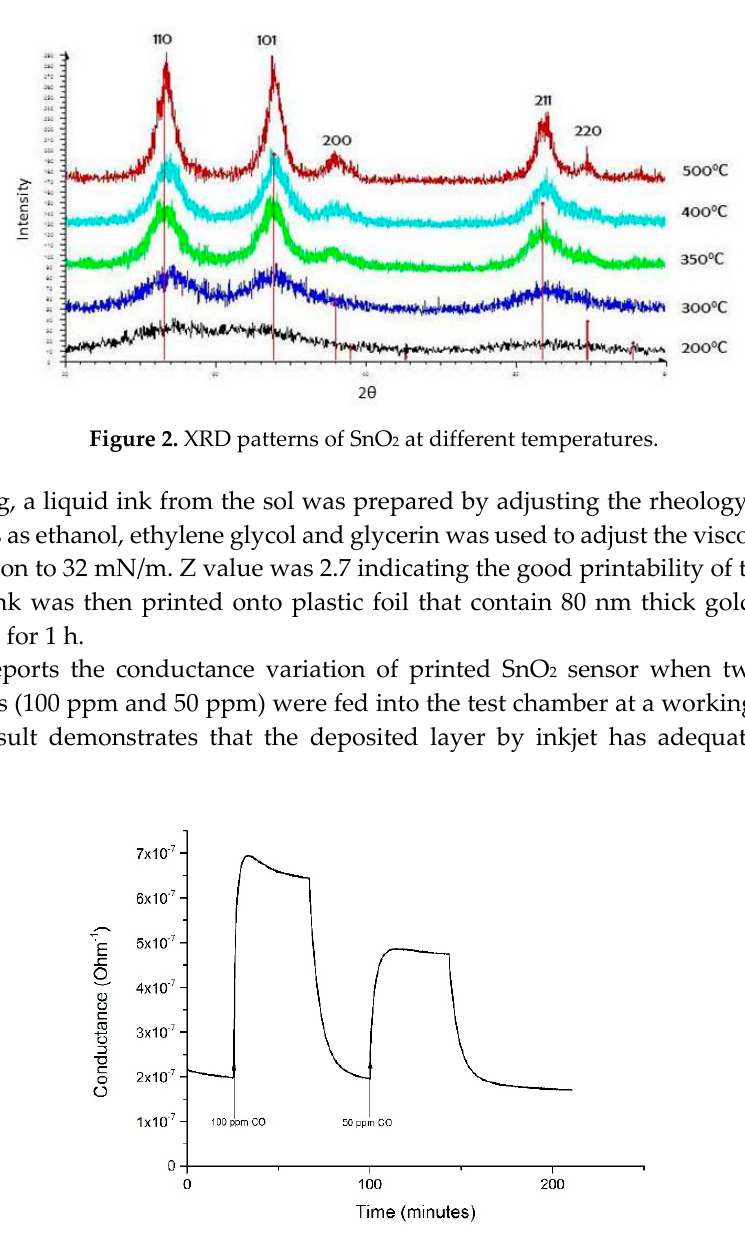
Figure 1. Thermal analysis by TGA/DSC of the sol based SnO 2 .